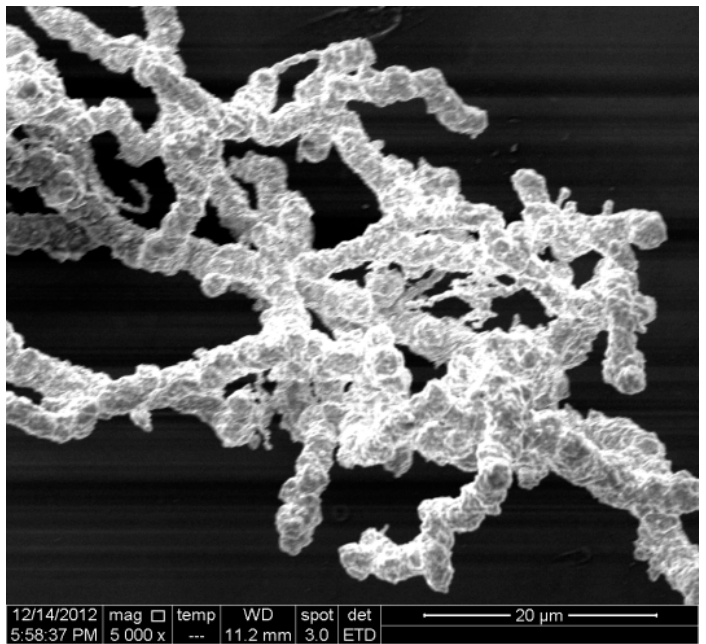
Figure 11. Three-dimensional branched structure of nickel nanostrands [132].